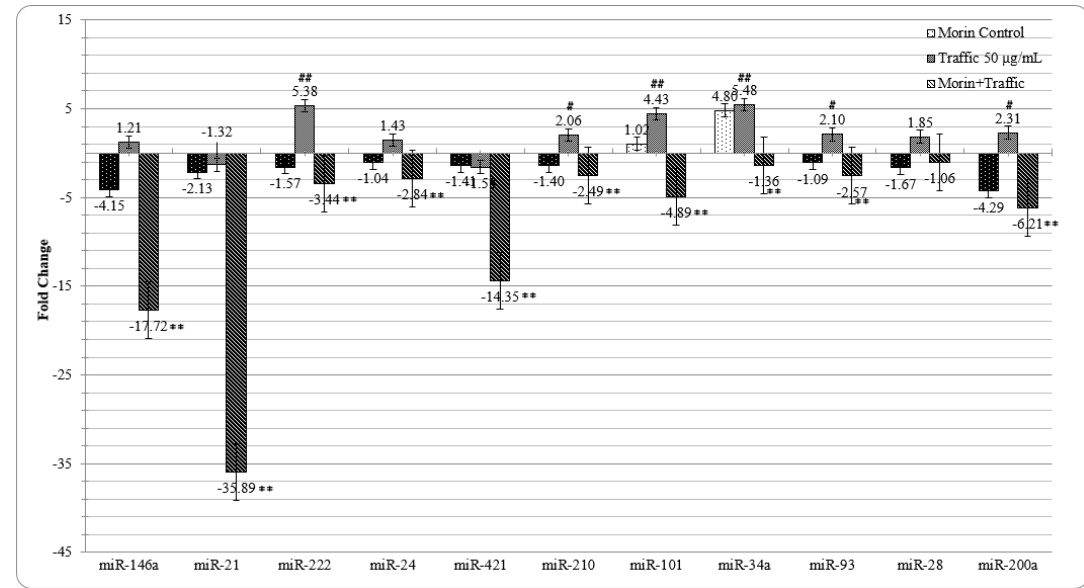
Figure 7. Morin and traffic PM 2.5 on miRNA expression in A549 cells, N = 3 ± SD. # p < 0.05, ## p < 0.01 compared to the untreated control cells, ** p < 0.01, compared to PM 2.5 -treated cells.